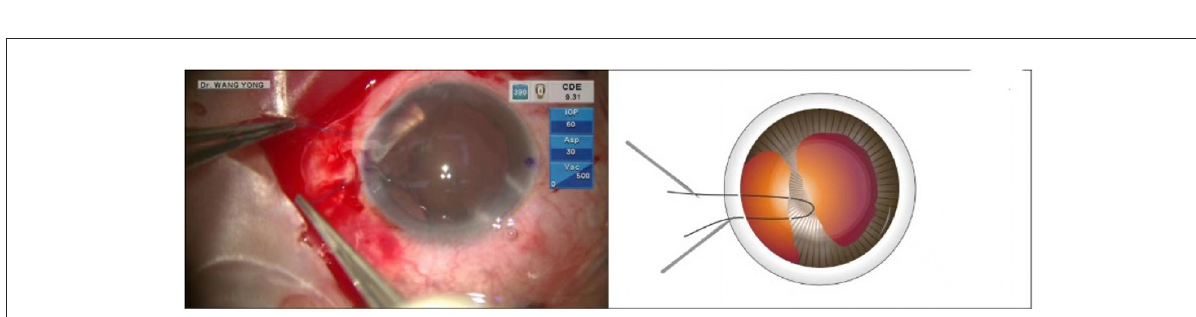
FIGURE3 The suture was tightened to make the iris root adhere to the corneal limbus.